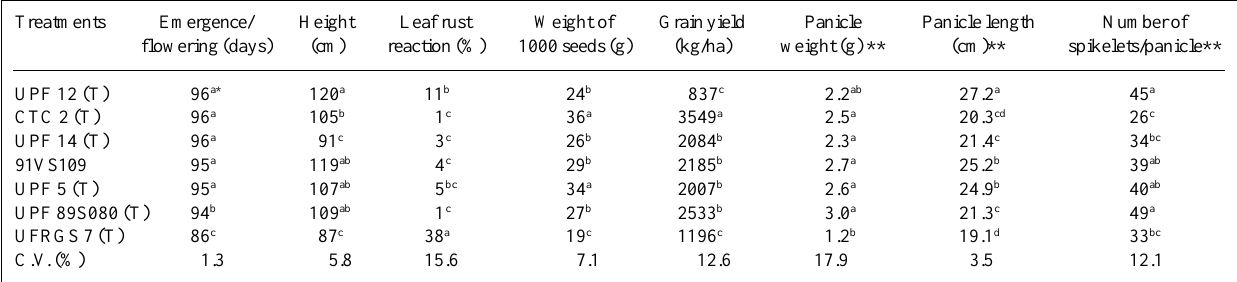
Table III - Comparison of means from oat somaclone 91VS109, derived from cultivar UFRGS 7, and controls for the following characteristics: days between emergence and flowering, plant height, leaf rust reaction, weight of a 1000 seeds, grain yield, panicle weight and length